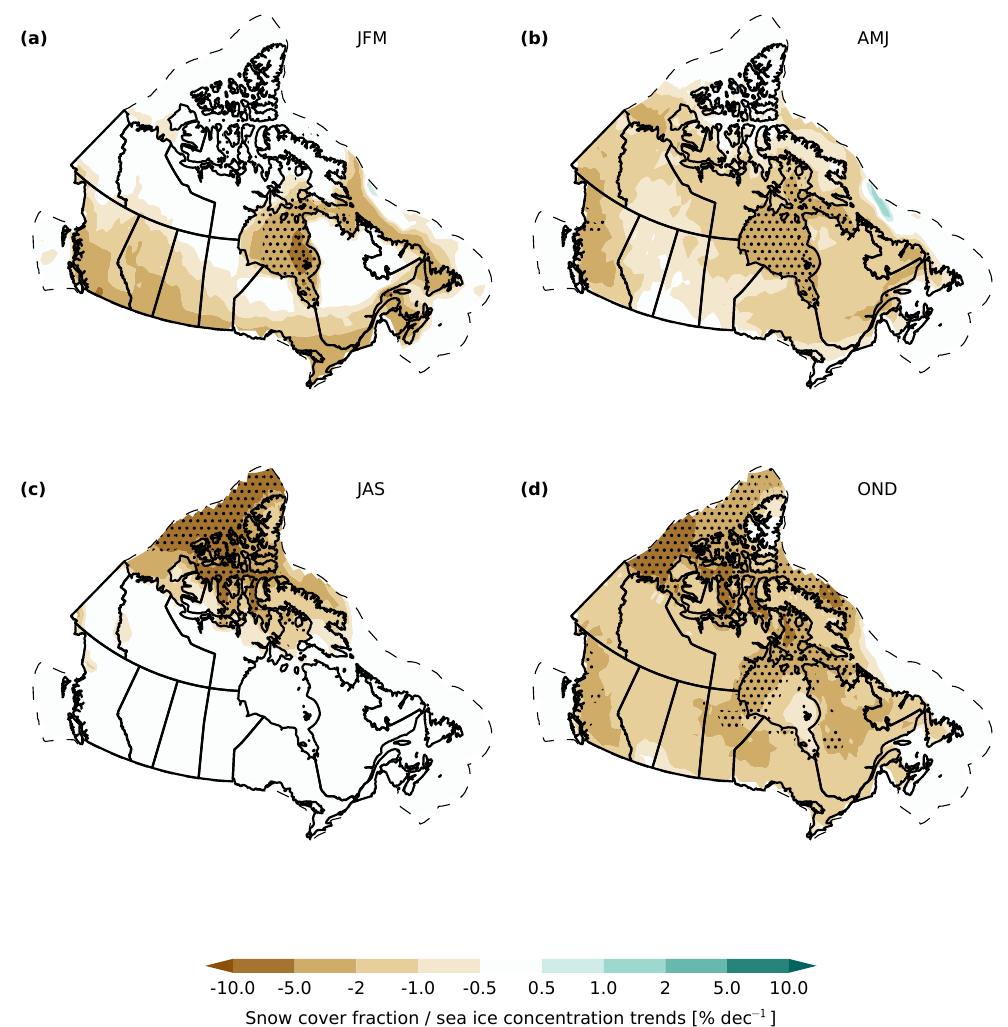
Figure 9. Projected terrestrial snow cover fraction and sea ice concentration trends for 2020–2050. Model simulations are described in Sect. 2.2. Stippling indicates pointwise significance at the 90th